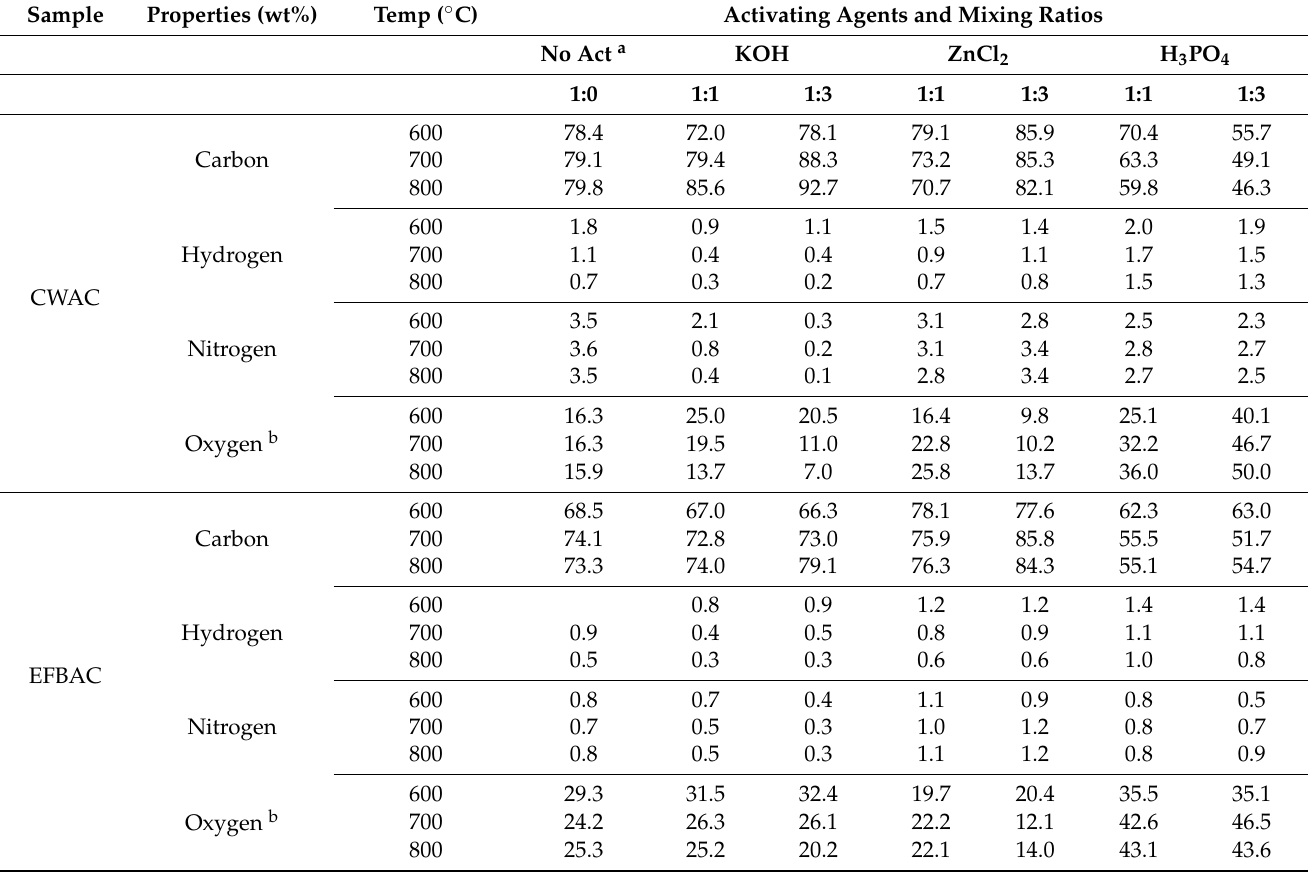
Table 3. Determination of elemental composition of activated